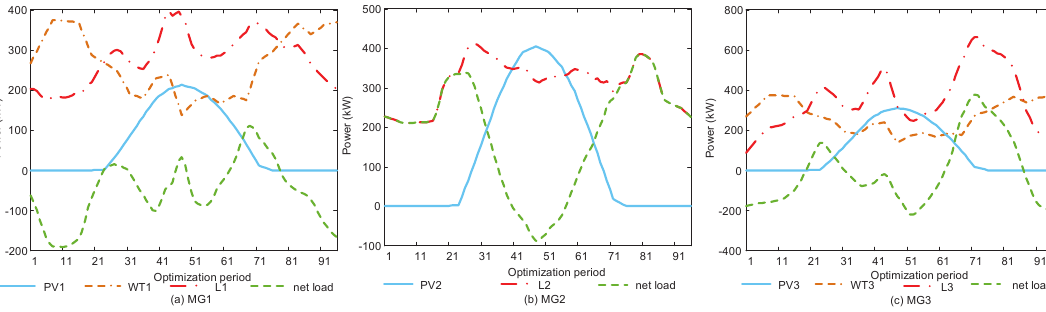
Figure 6. The PV power, WT power and load power in each MG on Day 1 of Scenario 1 (( a ) MG1; ( b ) MG2; ( c )